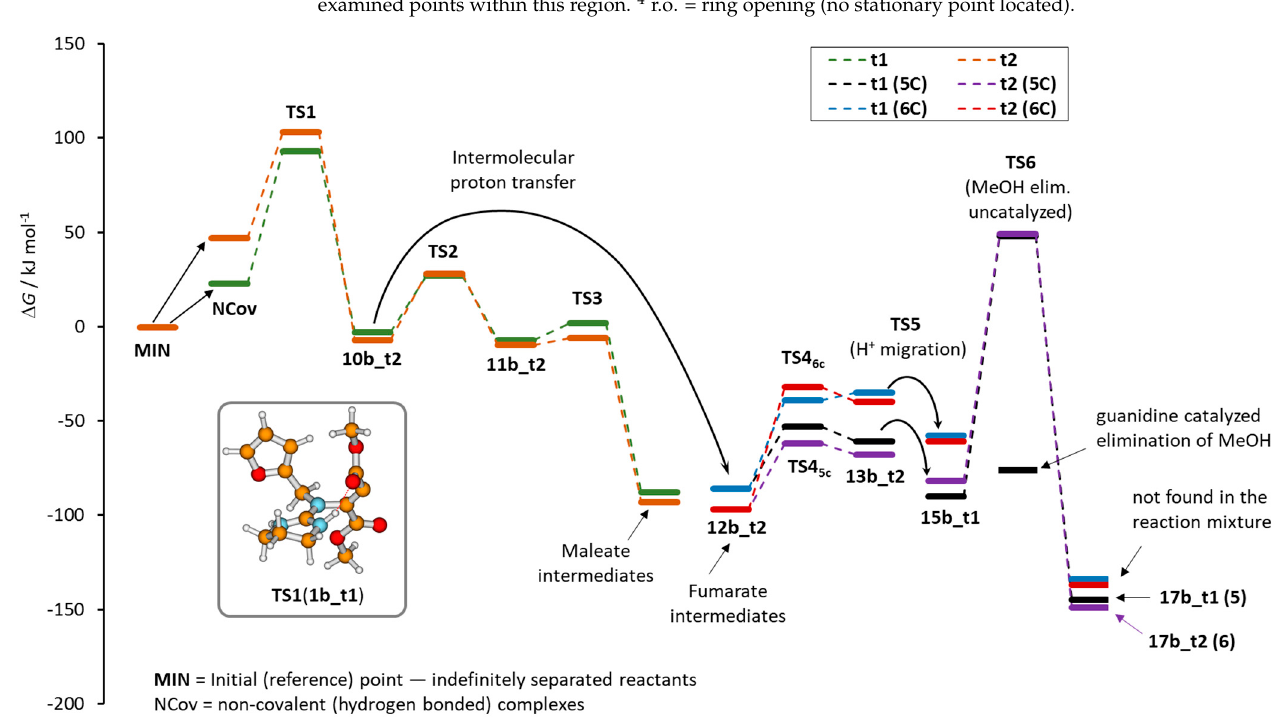
1 All energies are given in kJ mol − 1 ; the labels 5C and 6C refer to the ring size formed upon the intramolecular cyclization step. 2 All structures of products were calculated as the complexes with methanol; values in parentheses refer to the E -isomers of the corresponding structures. 3 i.p. = inflection point, the relaxed scan calculations starting from the 13c structures indicated a flat region of the potential energy surface with NImag = 0 at several examined points within this region. 4 r.o. = ring opening (no stationary point located).